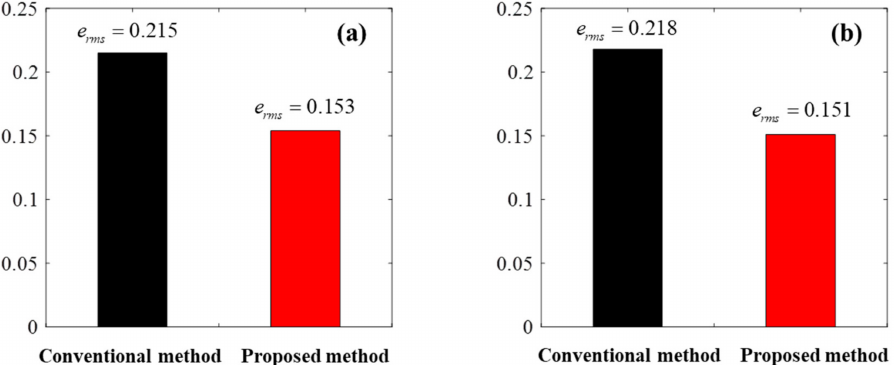
Figure 12. Quantitative comparison (root mean square error) in the ( a ) normal braking case and the ( b ) ABS control